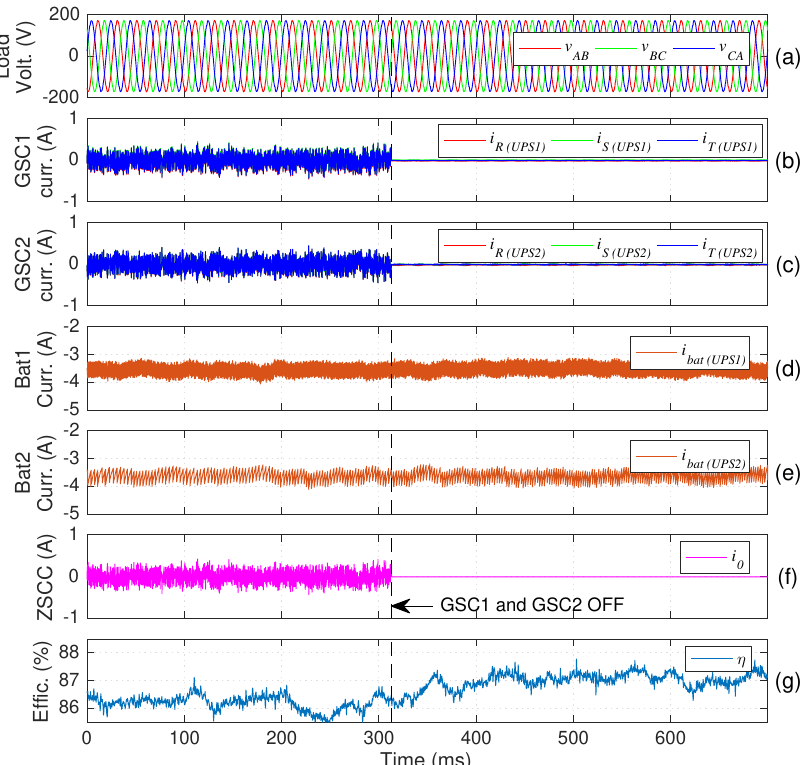
Figure 14. Impact of GSC pulses deactivation in system efficiency during stored energy mode: ( a ) Load Voltage; (b) UPS1 grid currents; ( c ) UPS2 grid currents; ( d ) UPS1 battery current; ( e ) UPS2 battery current; ( f ) Zero Sequence Circulating Current; ( g ) Global system